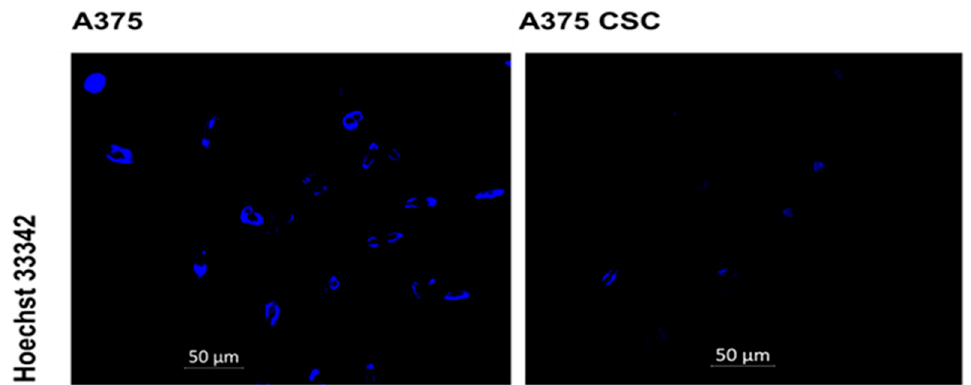
Figure 4. Nuclear stain with the Hoechst 33342 dye, and fluorescence microscopy of the A375 subpopulation and the total A375 cell population revealed a higher fluorescence intensity in the total cell population, whereas a lower fluorescence intensity was observed in the subpopulation.